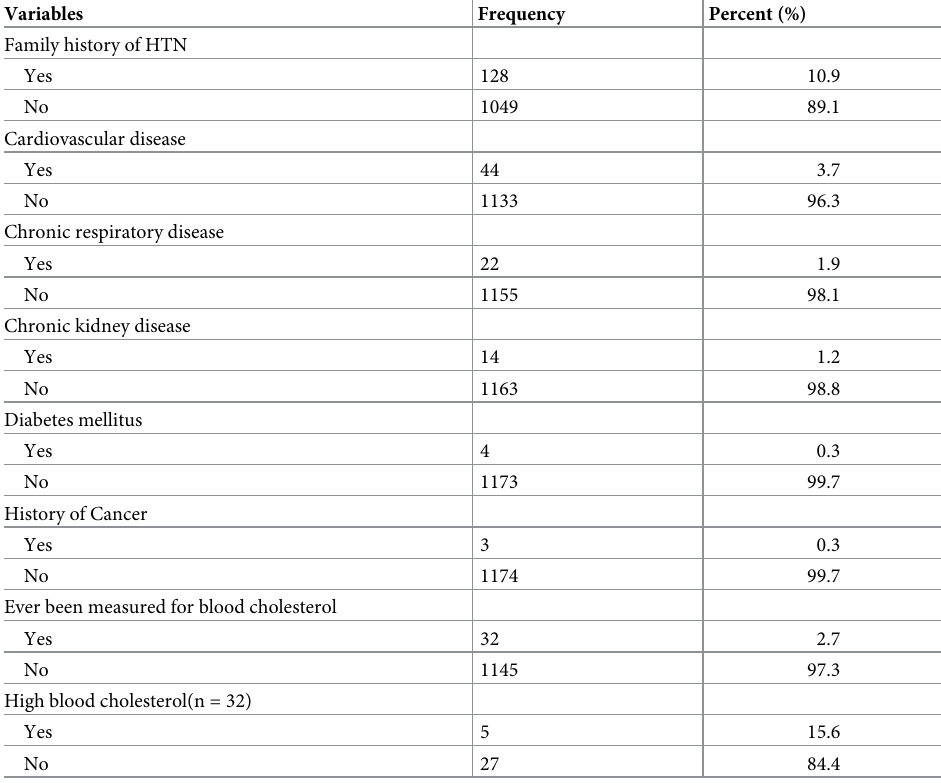
Table 2. Co-morbidities and FHH related characteristics of participants in northwest Ethiopia, June-October 2020.